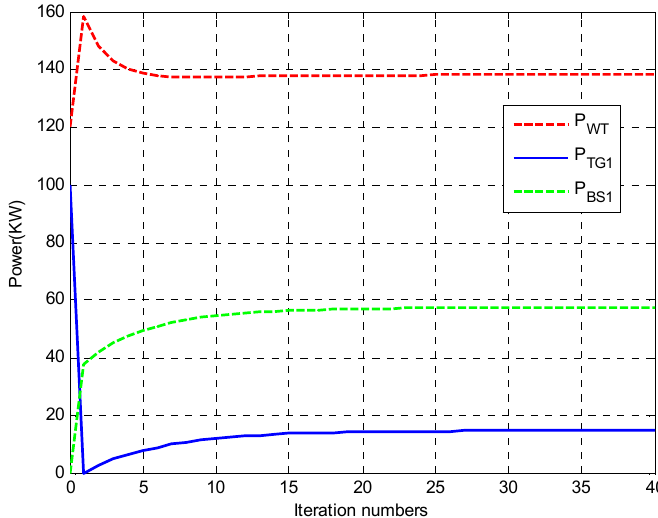
Figure 5. Power output of the AC side node of a single period in the AC sub-grid.